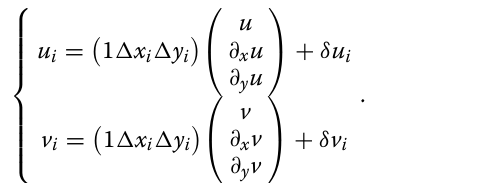
Equation (2) corresponds to the Taylor expansion of the velocity field at the first order. Equation (2) indicates that, as long as the errors (δ u i , δ v i ) are mutually independent, the estimations of pendent of each other. Therefore, we explain the method for one velocity component in the following. We have velocity data v i with variance (observation consider a multiple regression model at each estimation point P